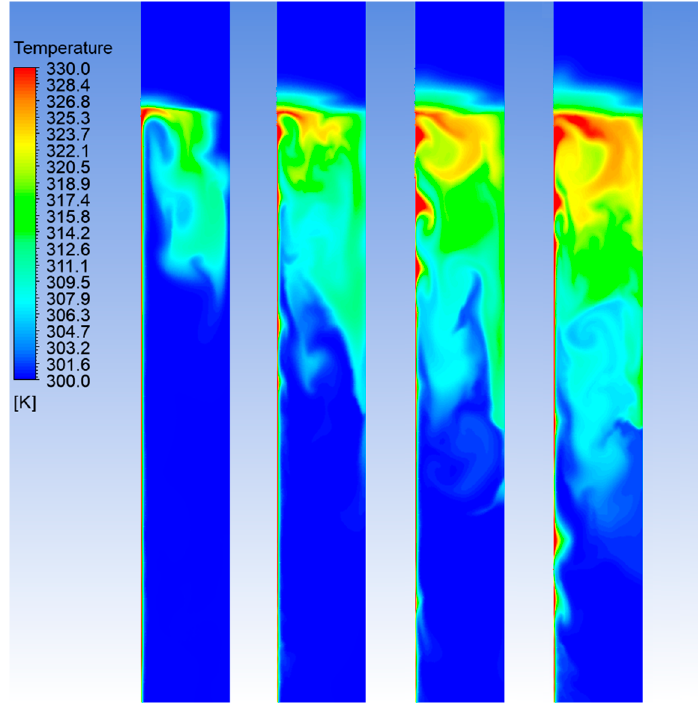
Figure 3. Temperature field in the batch reactor, for the case of power input of 4.0 kW. From left to the right: 20, 40, 60 and 80 s after the start of the process.